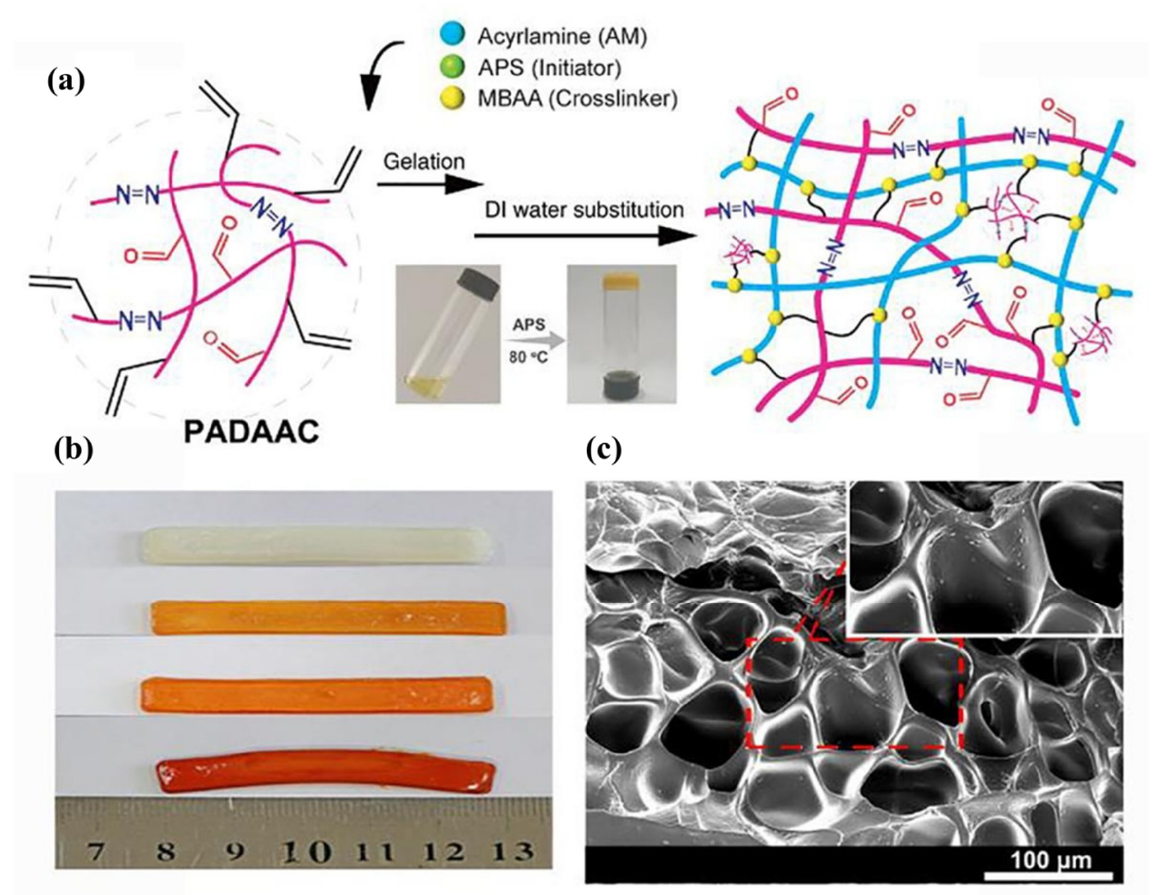
Figure 22. ( a ) Schematic crosslink of PADAAC with AM and MBAA initiated by APS to fabricate hydrogels. ( b ) The color of different contents. ( c ) SEM of lyophilized hydrogel as described by She et al. Adapted with permission from [61]; pub- lished by Elsevier,